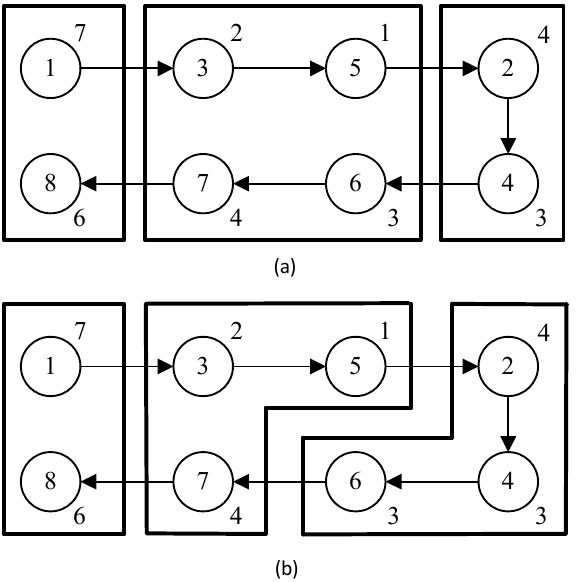
Figure 6. An example result of task allocation, ( a ) original; ( b ) final.